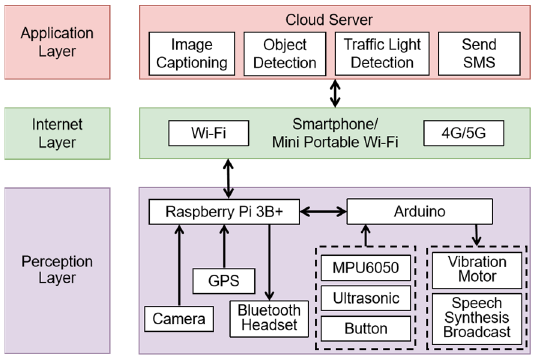
Figure 2. IoT architecture of the intelligent assistance cane.